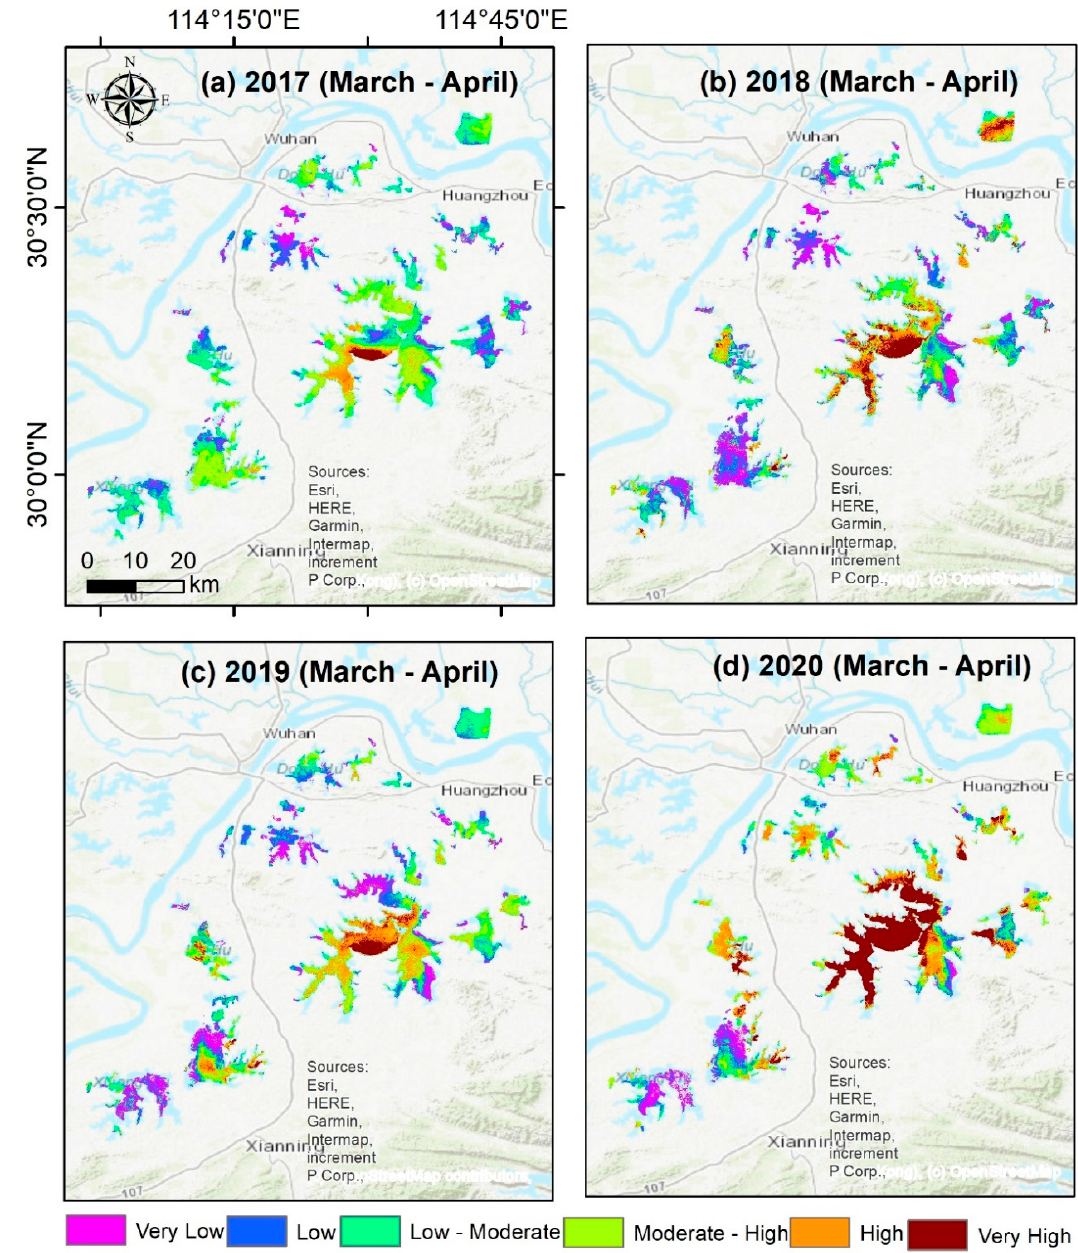
Figure 6. Mean chlorophyll- a concertation mapped for ( a ) 2017, ( b ) 2018, ( c ) 2019, and ( d ) 2020 during April–May months (for simplicity, the chlorophyll index algorithm [14] is used in Google Earth Engine (GEE) to derive the low to high classes).